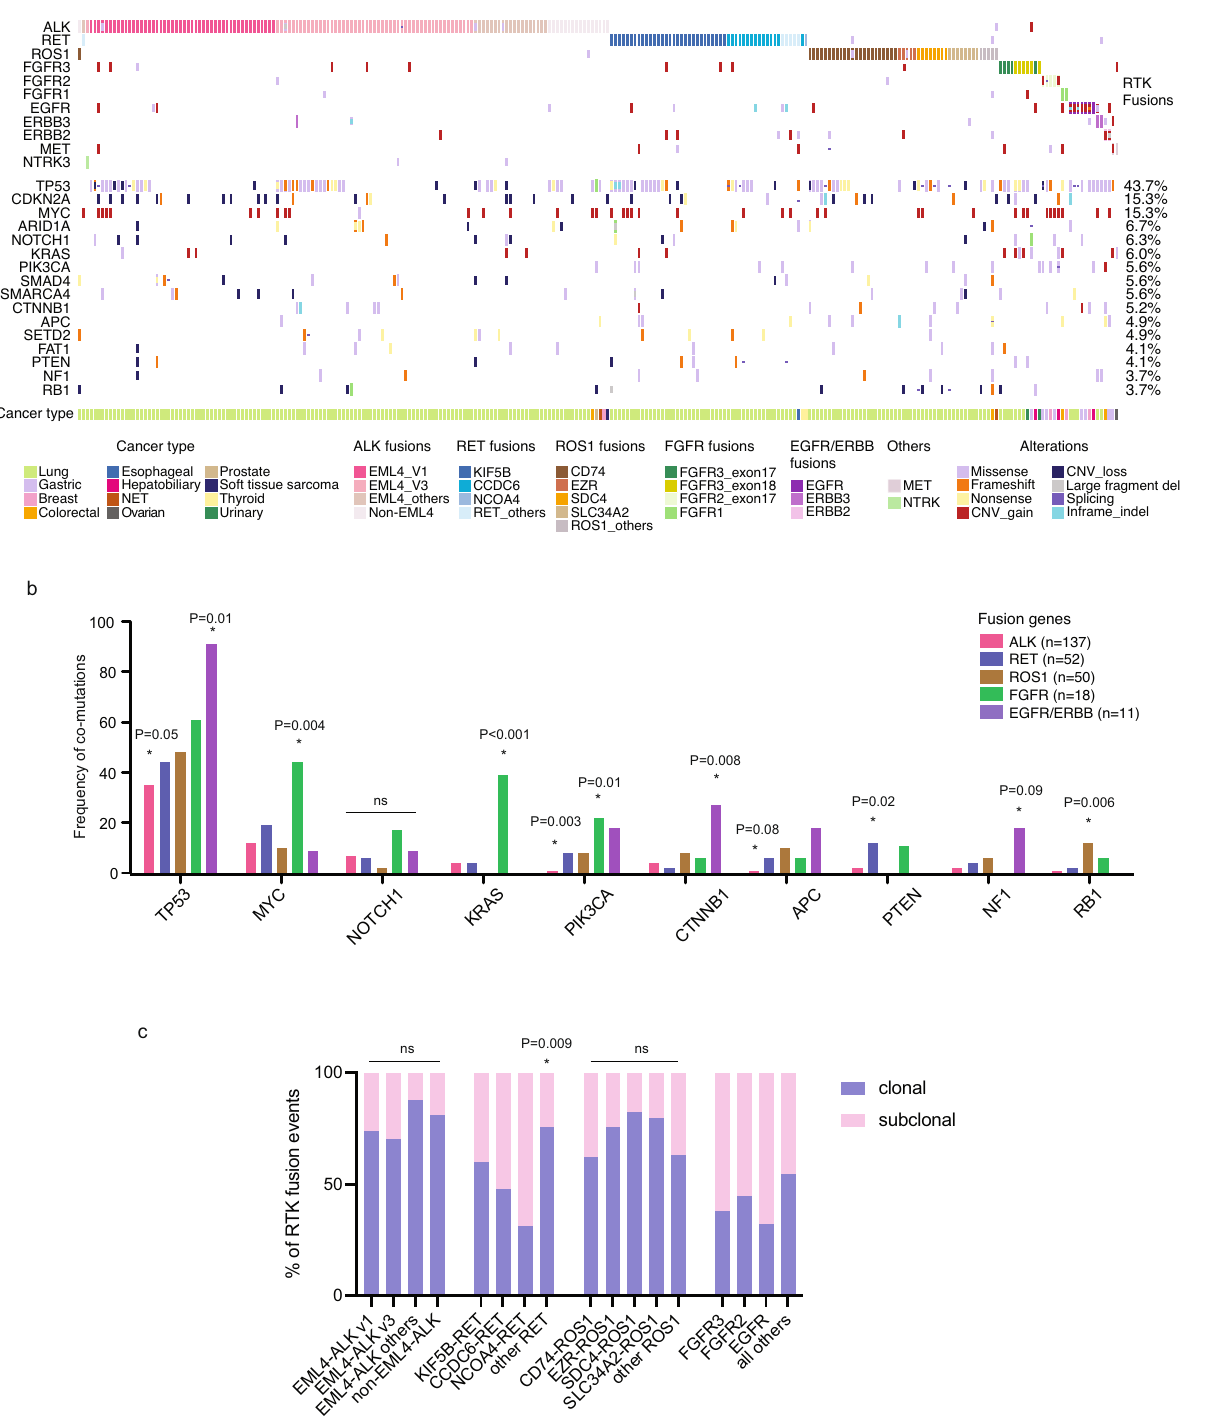
Fig. 3 Mutational landscape of concomitant mutations prior to TKI treatment. a Oncoplot showing the most frequently co-mutated genes across different RTK fusion-positive samples. b Different RTK fusions are associated with varying spectra of concomitant mutations, P values using Bonferroni ’ s post-test are as indicated. c Estimated clonality comparing different fusion genes or fusion